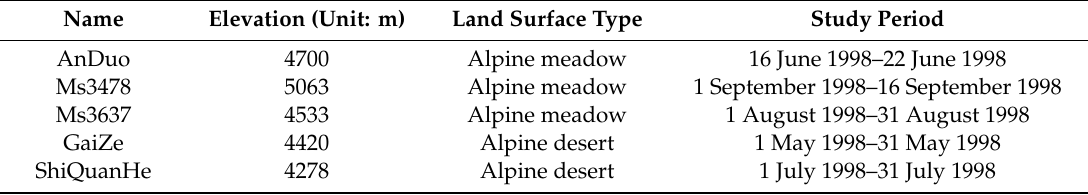
Table 1. Descriptions of the selected observational